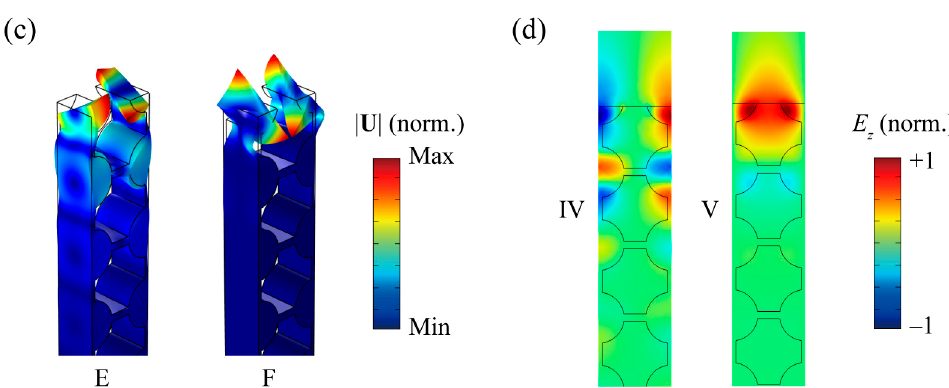
Figure 11. Dispersion curves of the surface wave bands of phononic ( a ) and photonic odd ( b ) modes for different τ , where τ increases from 0.05 to 0.2 with a step of 0.05. The cyan and gray areas represent the projected bulk modes and light cone, respectively. ( c ) Displacement field distributions and deformed patterns corresponding to different phononic surface bands. ( d ) Electric field ( E Z ) distributions at plane z = 0 corresponding to different photonic surface bands.